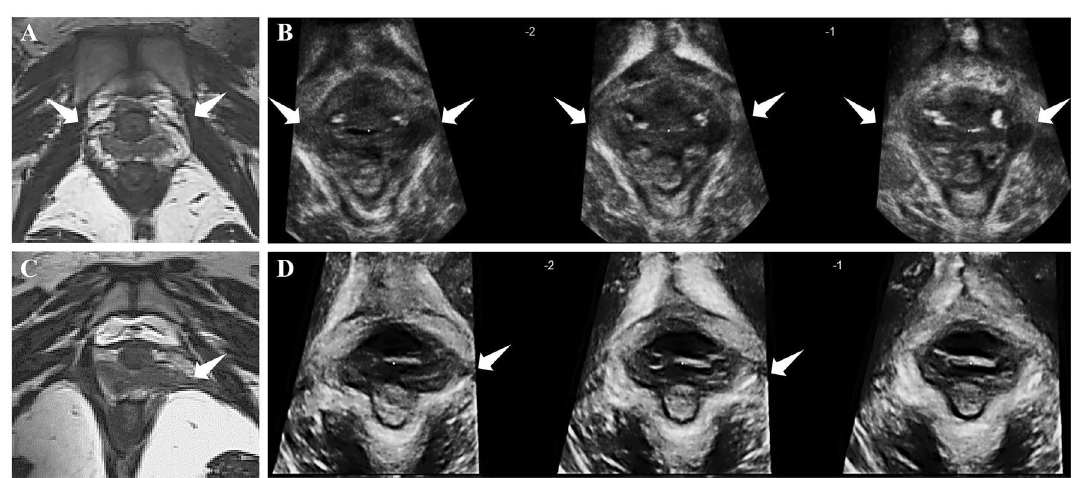
Figure 1. The magnetic resonance image showed the bilateral avulsion ( A ) and left avulsion ( C ). The tomographic ultrasound images showed complete avulsions at the both sides on the three central slices ( B ) and partial avulsion at left side on the three central slices ( D ). White arrows pointed the positions of the levator ani